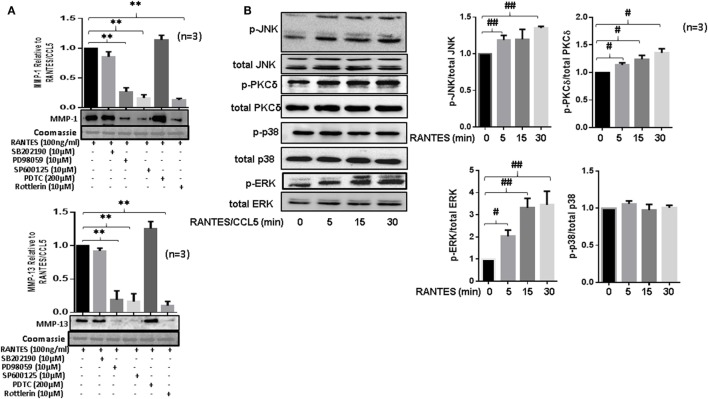
Regulated on activation, normal T expressed, and secreted (RANTES)/CC ligand 5 (CCL5) selectively activates PKCδ and JNK pathways to induce matrix metalloproteinase (MMP)-1 and MMP-13 production in rheumatoid arthritis synovial fibroblast (RASFs). (A) RASFs were pretreated with p-38 inhibitor (SB203980; 10 µM), ERK inhibitor (PD98059; 10 µM), JNK inhibitor (SP600125; 10 µM), NF-KB inhibitor (PDTC; 200 µM), or PKCδ inhibitor (Rottlerin; 10 µM) for 2 h followed by stimulation with RANTES/CCL5 for 24 h. Culture supernatant were concentrated to determine MMP-1 and MMP-13 expression using Western immunoblotting. Densitometry was performed to determine the relative changes. Gels were stained with Commassie Blue R250 stain to ensure equal loading. (B) Effect of RANTES/CCL5 (100 ng/ml) on the MAPK (p38, JNK and ERK) and PKCδ pathways was studied in human RASFs. RASFs were treated with RANTES (100 ng/ml) for different time (5, 15, and 30 min) and effect on phosphorylation of p38, JNK, ERK, and PKCδ was determined using Western immunoblotting. Total forms of p-38, JNK, ERK, and PKCδ were used as normalizing controls, respectively. Densitometry was performed to show the relative changes. Values are represented as mean ± SE from three or more independent experiments using cells from different donors under similar conditions. **p < 0.01 for RANTES/CCL5 vs. inhibitors; #p < 0.05 or ##p < 0.01 for NS vs. RANTES/CCL5.